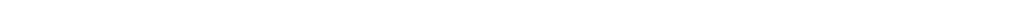
Fig. 1 Mutational pro fi ling of the PI3K pathway and the clinical features of 149 breast cancers. a Tumor samples grouped by subtype: luminal A ( n = 32), luminal B ( n = 75), HER2-enriched ( n = 17), and basal-like ( n = 25). The total number of mutations in each case and in each gene is illustrated. The percentage of mutations in each gene is shown on the right. b Comparison of mutation frequencies in our pro fi ling with those in the TCGA data set. Higher frequencies of mutations in PIK3R1 , AKT1 , AKT2 , and AKT3 were observed in the FUSCC cohort. The distributions of the mutations with respect to cancer subtype are indicated by color. c Comparison of PIK3CA mutation frequency in the FUSCC and TCGA data sets according to breast cancer molecular subtype. d The PIK3CA protein possesses fi ve domains: an adapter-binding domain (ABD), a Ras-binding domain (RBD), the C2 domain, a helical domain, and the PI4K kinase catalytic domain. The substitutions shown at the top are the non-synonymous mutations that were identi fi ed in the current study; the substitutions shown on the bottom are the non-synonymous mutations described in the TCGA and COSMIC data sets. The novel identi fi ed mutations are highlighted in red. Each fi lled circle represents an individual mutated tumor sample, whereas different colors indicate the tumor subtypes: luminal A (purple), luminal B (blue), triple-negative (red), and HER2-enriched (yellow). e Comparison of PIK3R1 mutation frequencies among different tumor subtypes in FUSCC and TCGA. f Schematic structure of PIK3R1 . g Multiple somatic mutations in the major components in the PI3K pathway were found